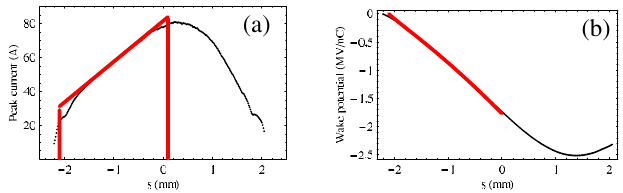
FIG. 4. (Color) (a) Electron distribution with a linear ramped peak current and (b) a correspondent wake potential calculated (cid:2) 1 : 28 mm , and L (cid:2) 24 m . The red line for a (cid:2) 9 : 73 mm , s 0 acc shows a desirable ideal distribution and its associated wake potential. The black line shows the realistic electron density distribution obtained in the photoinjector using the intensity shaped laser pulse (a), and the wake potential that corresponds to that distribution (b). The part under the red line contains approximately 40% of the total charge containing under the black line.